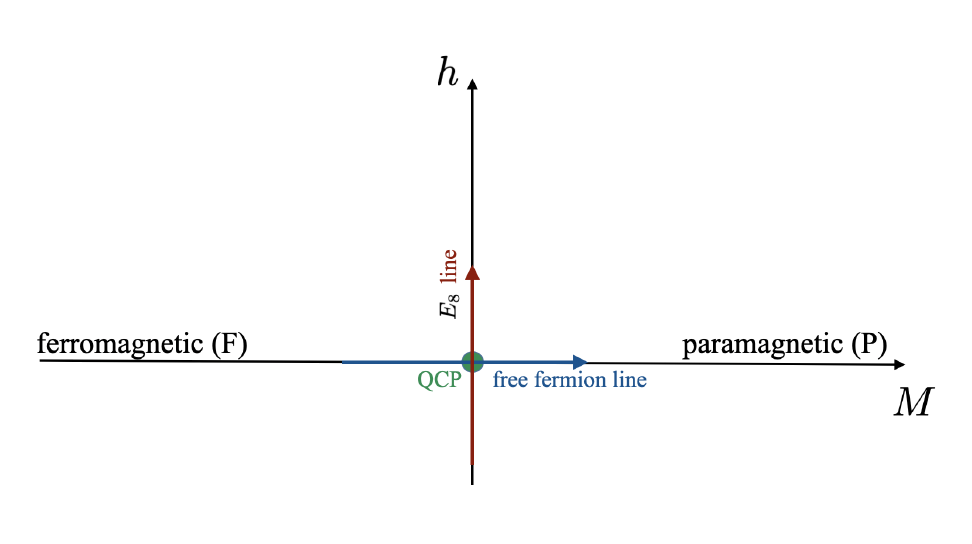
Figure 2.1: Phase diagram of the Ising Field Theory. The couplings M and h charac- terise the strengths of the perturbations of the c = 1 / 2 conformal field theory by its two relevant operators, (cid:34) and σ . The KZM is studied for ramps along the integrable directions indicated by the coloured